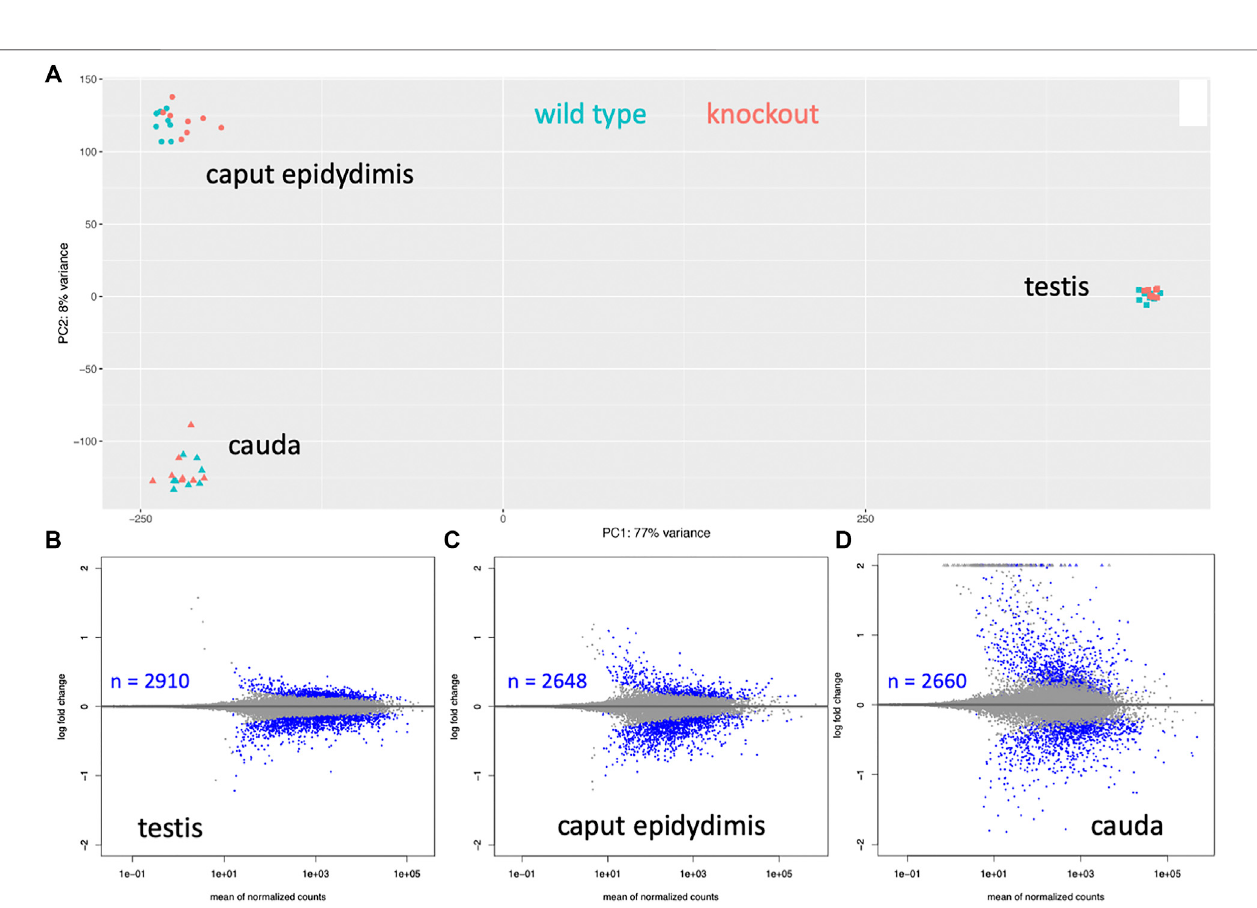
FIGURE 5 | Whole transcriptomes analysis of three tissues from wild type versus knockout mice. (A) Overall PCA comparison. Strong differentiation is seen between the tissue samples, implying that those transcript sets are very different. The differences between wild type and knockouts are much smaller for each tissue. (B – D) Signi fi cantly differentially expressed genes. A dot represents each gene, genes with p adj < 0.05 values are plotted as blue dots. The number of signi fi cantly differentially expressed genes is provided as an inset for each tissue.